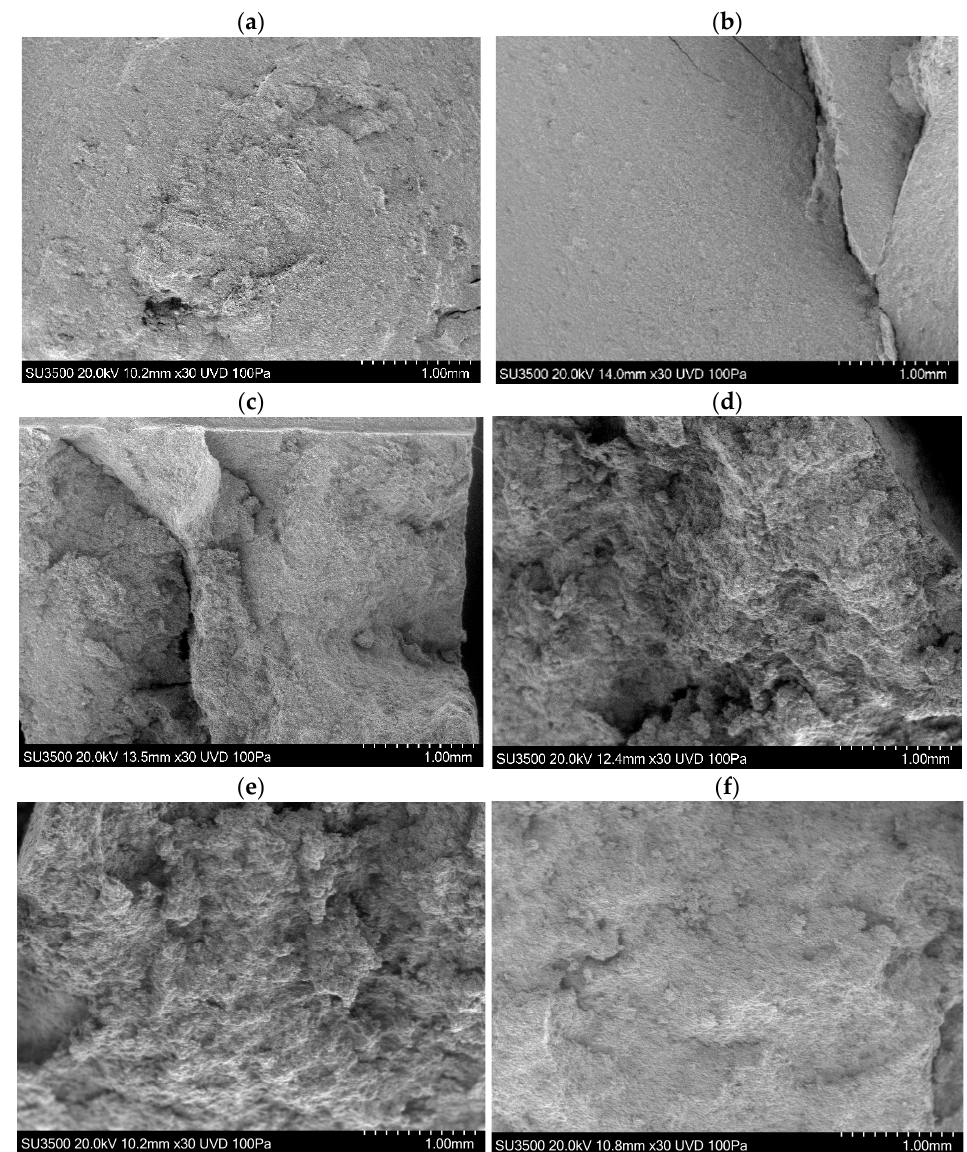
Figure 9. SEM Images of Ash A displaying the brittle–ductile transition. (a) Specimen tested at 400 °C—Brittle; (b) Specimen tested at 450 °C—Brittle; (c) Specimen tested at 450 °C—B/D; ( d ) Specimen at 400 ◦ C —Brittle; ( b ) Specimen tested at 450 ◦ C—Brittle; ( c ) Specimen tested at 450 ◦ C—B/D; tested at 450 °C—Ductile; (e) Specimen tested at 475 °C—Ductile; ( f ) Specimen tested at 500 °C— ( d ) Specimen tested at 450 ◦ C—Ductile; ( e ) Specimen tested at 475 ◦ C—Ductile; ( f ) Specimen tested Ductile. at 500 ◦